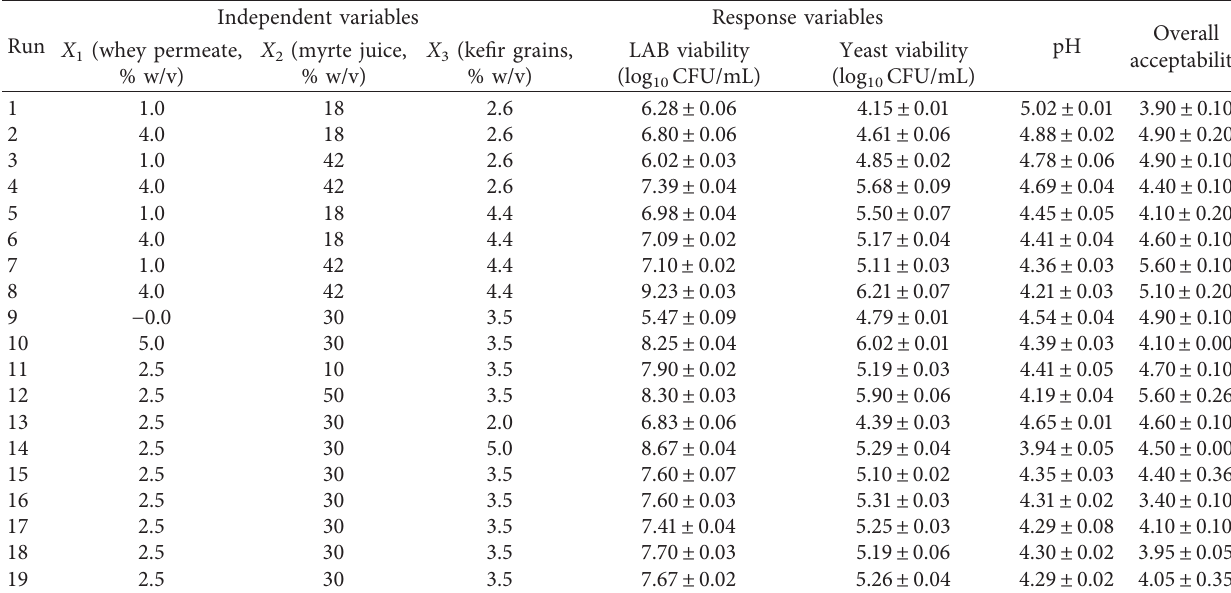
Table 3: Matrix of the central composite design for three variables and the measured responses (LAB viability, yeast viability, pH, and overall